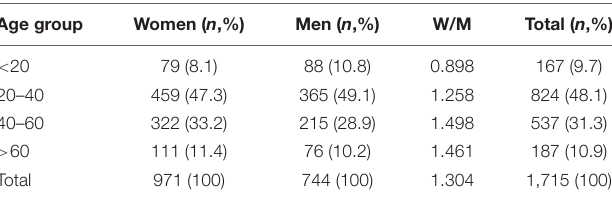
TABLE 1 | Age and gender composition of survey